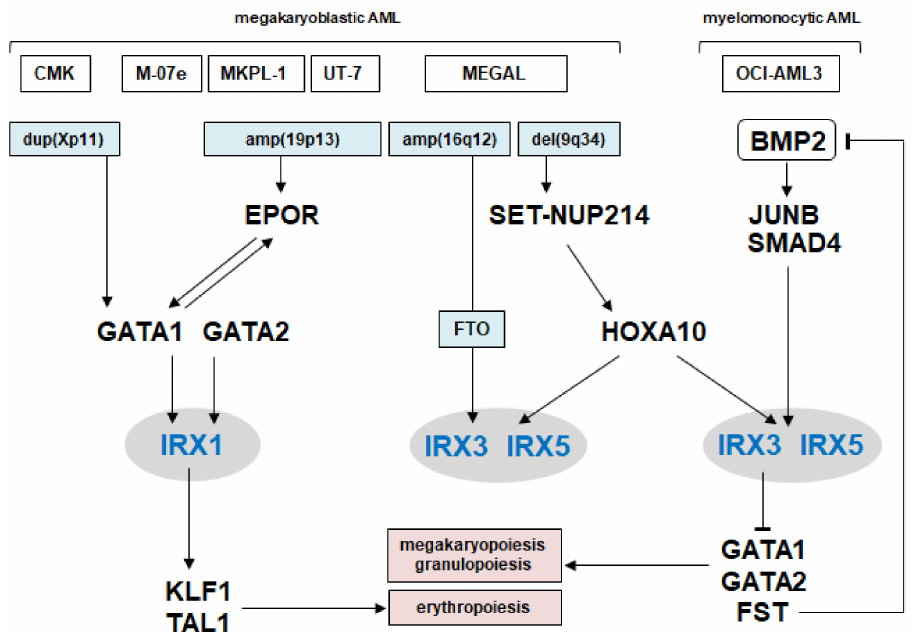
Figure 7. Gene regulatory network of IRX1 and IRX3/IRX5 in AML. The figure summarizes the results of this study. TALE homeobox genes IRX1, IRX3, and IRX5 are located centrally, chromosomal aberrations lie upstream, and developmental TFs and BMP2-signaling components both upstream and downstream. Thus, these IRX genes are part of a regulatory gene network, controlling myeloid